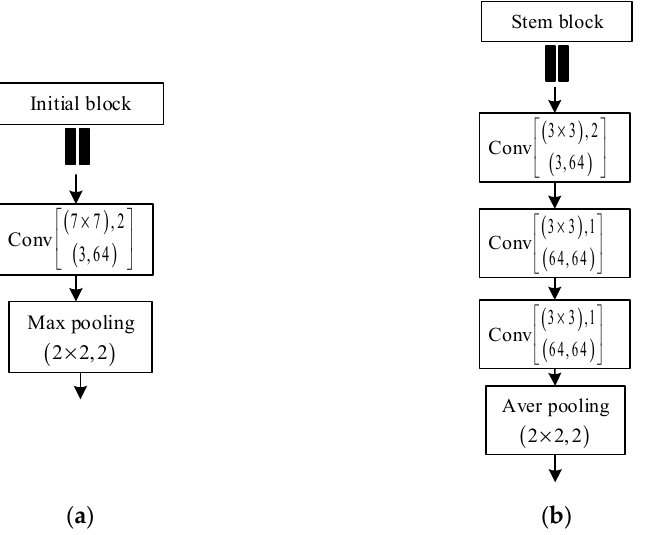
Figure 6. Relation between initial and stem blocks: ( a ) the initial block; ( b ) the stem block.